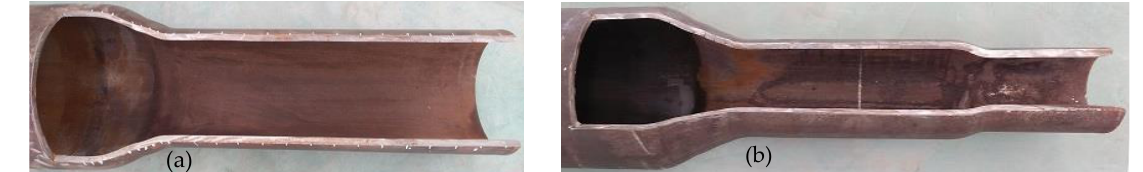
Figure 29. Reduced tube of PPDR. ( a ) The first pass; ( b ) the fourth pass. Comparison of the EXP and FEA value of end warpage and unevenness between PDR and PPDR is shown in Table 9. The comparison results showed as follows: Table 9. Comparison results (mm). Reducing Pass.